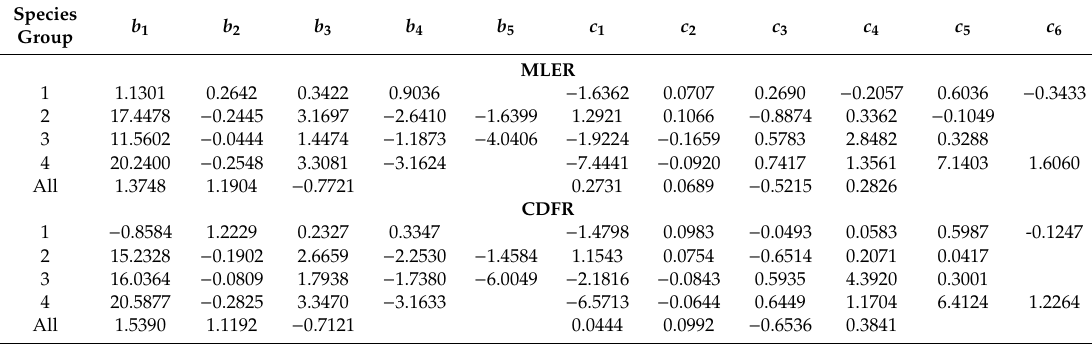
Table 3. Coe ffi cients ( b 1-5 , c 1-6 ) of regression equations in Table 2, by species code and fitting